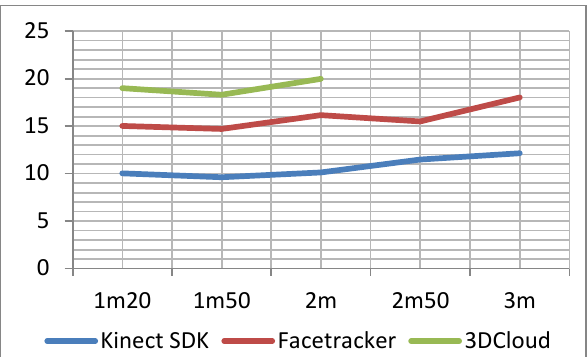
Figure 19. Mean RMSE (in degrees) for the yaw function of the viewer distance from TV (in